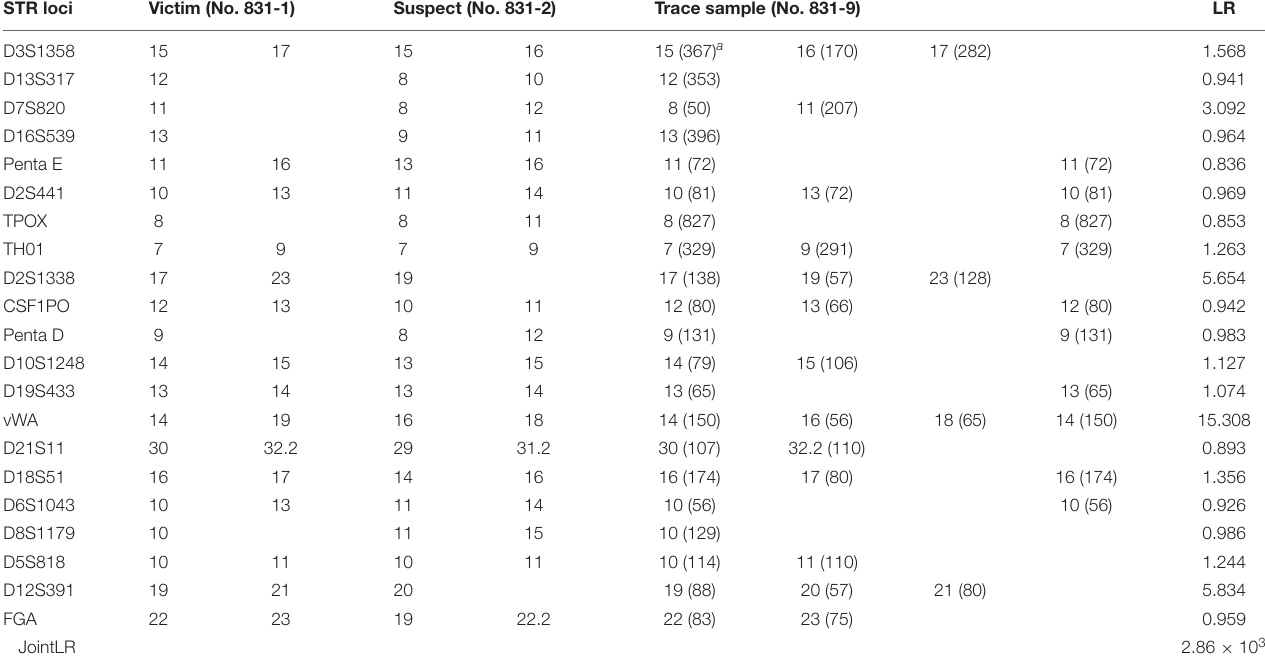
TABLE 6 | Autosomal STR profiling results of the victim, suspect, trace sample and resulting LR values. STR loci Victim (No. 831-1) Suspect (No. 831-2) Trace sample (No. 831-9)